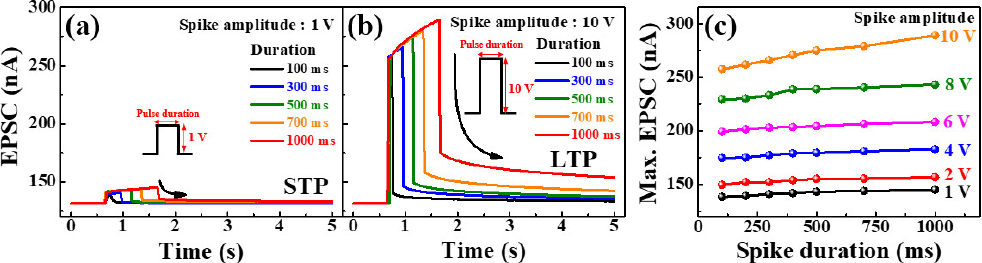
Figure 5. Single spike excitatory post-synaptic current (EPSC) curves of the sol-gel composites-based synaptic transistors with amplitudes of ( a ) 1 V and ( b ) 10 V for various pulse durations. ( c ) Maximum EPSC with various spike durations and amplitudes.